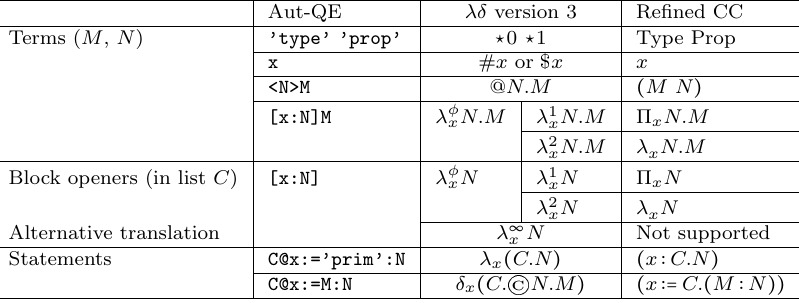
Fig. 12. The translation scheme for the QE-GdA.